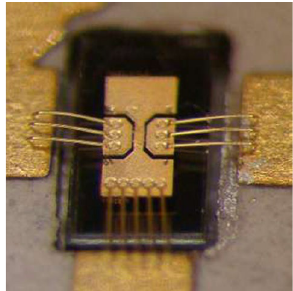
Figure 1. Photograph of the GaN transistor mounted in the oscillator PCB. Chip dimensions are 660 × 210 µm 2